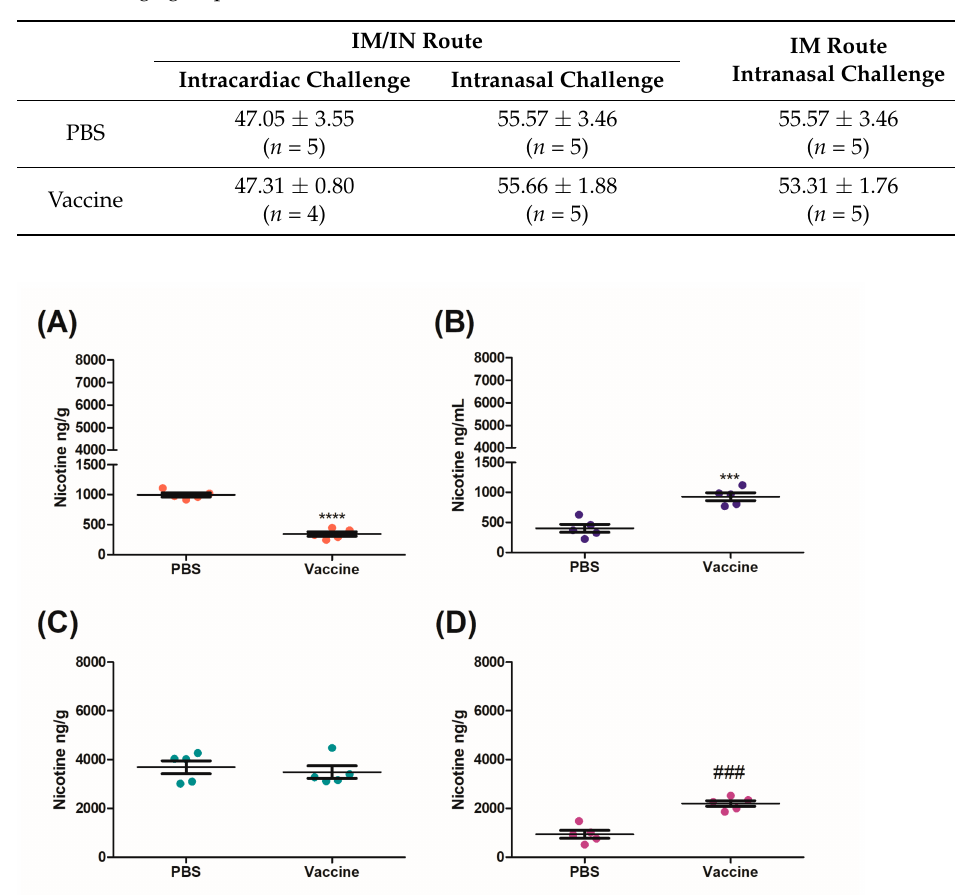
Figure 4. Distribution of nicotine in mice vaccinated IM after a mucosal nicotine challenge. IM vaccinated mice were challenged with 0.09 mg/kg of nicotine by an IN instillation of 10 µ L per nare. After 10 min the mice were euthanized by a cardiac exsanguination and organs were collected for nicotine distribution analysis. ( A ) Brain, ( B ) sera, ( C ) lung, ( D ) heart and data are represented as ± SEM and n = 5 for each group. Statistical significances were determined by an unpaired two-tailed T-test, ### p = 0.0002, *** p = 0.0005 and **** p <